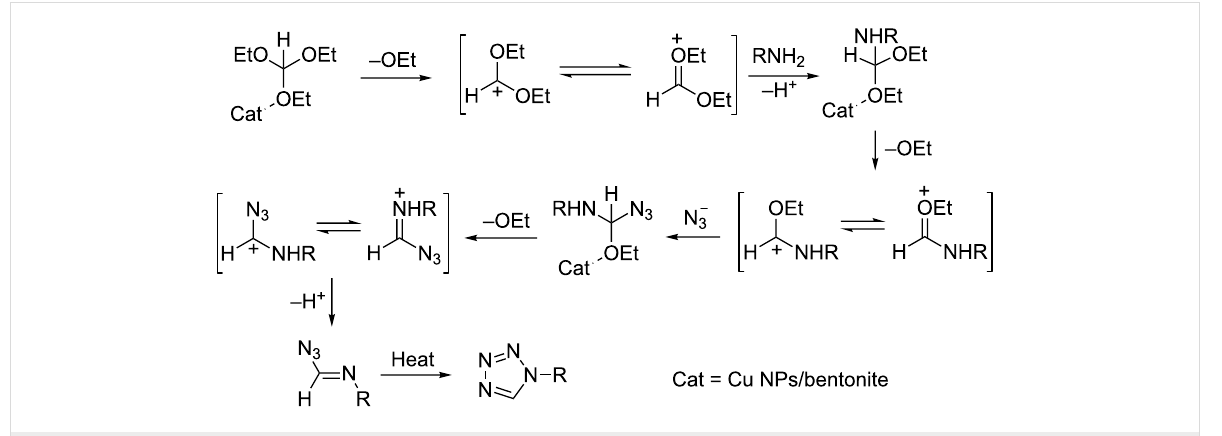
Scheme 3: The proposed mechanism for the preparation of 1-phenyl-1 H -1,2,3,4-tetrazole.